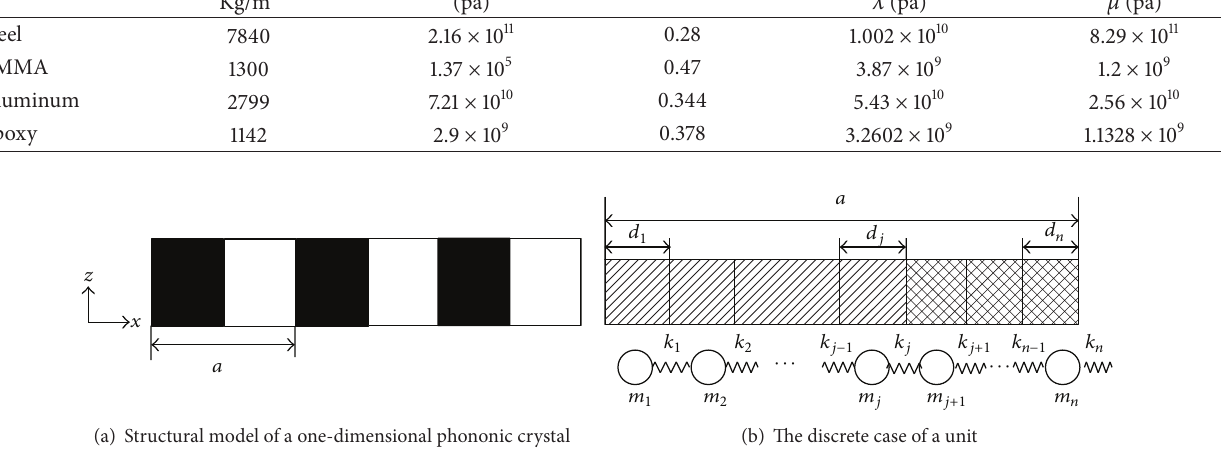
Figure 5: One-dimensional phononic crystal unit.